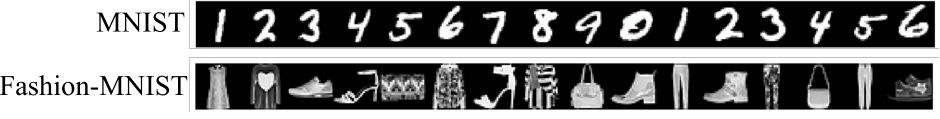
Figure 3. An example of grayscale handwritten digits and 10 fashion items from the dataset MNIST and